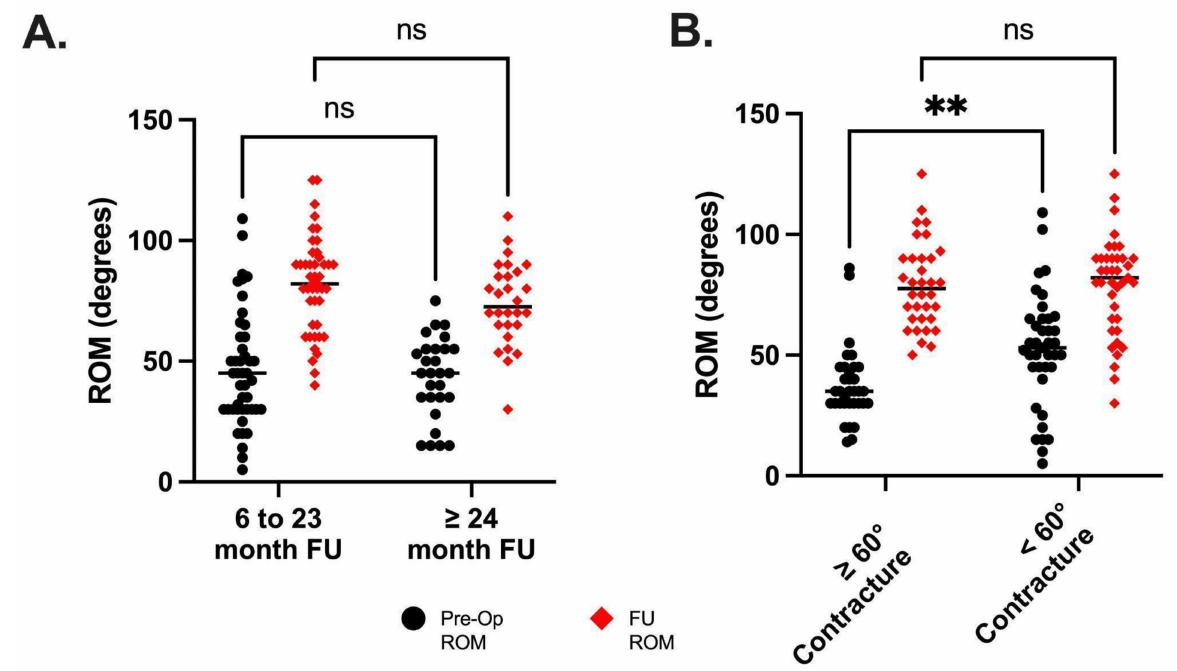
Figure 14. Sub analysis of ROM for patients with 6–23 months of follow up vs. ≥ 24 months of follow up ( A ). There were no differences in either pre- or post-operative range of motion, indicating that 6 months of follow up is sufficient to determine the effectiveness of treatment. ( B ) shows the sub analysis of range of motion for the patients who started with a flexion contracture of ≥ 60 ◦ . ** The range of motion was less before surgery but there was no difference in ROM post-surgery, indicating that even the patients with large flexion contractures reached a similar range of motion post-operatively.